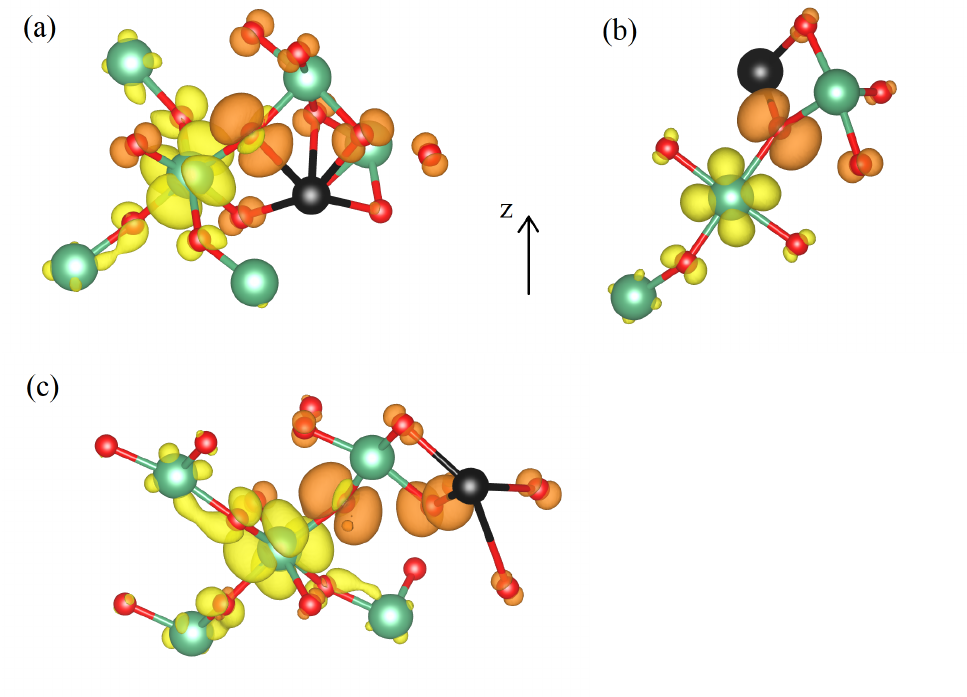
Figure 2. Partial charge densities of the exciton-polaron configurations EP-a ( a ) and EP-b ( b ), which are derived from the defect-bound hole polarons HP-a and HP-b shown in Figure 1, together with an example of a more extended complex, denoted as EP-d ( c ). Green, red, and black balls represent niobium atoms, oxygen atoms, and lithium vacancies, respectively. The yellow (orange) clouds show the spatial distribution of the electron charge (hole